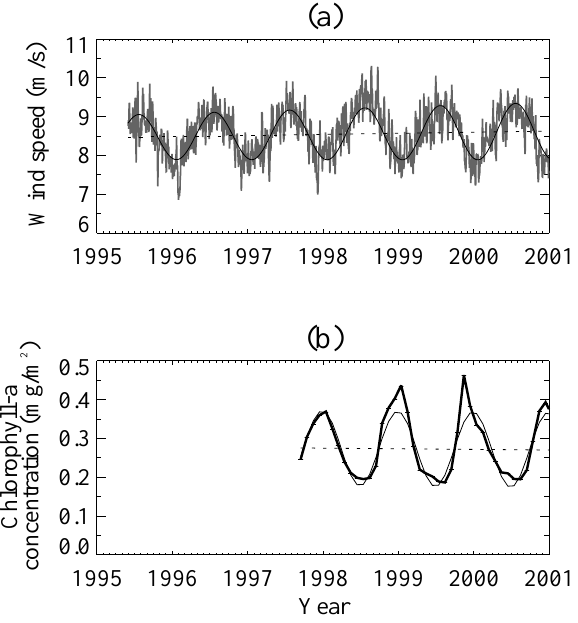
Fig. 10. Time-series of daily mean 10 m wind speed from ECMWF reanalysis (a) and monthly mean chlorophyll- a concentration from GlobCOLOUR (b) for the southern-most regions defined in Fig 8 (SPO, SAO and SIO). Fits to the time-series using Eq. (5) are given by the thin solid lines, and the linear component of these fits are shown by the dotted lines.